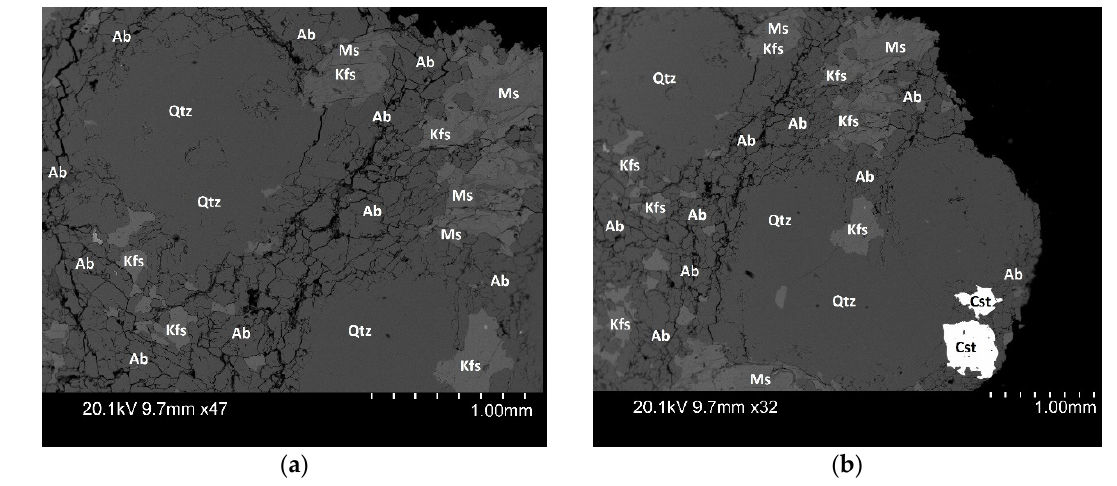
Figure 9. Backscattered electron image of two composite particles after IPB considering 20% compression ratio. The two composite particles ( a ) and ( b ) display unfractured quartz (Qtz) megacrysts, enclosed by a severely fractured matrix (albite (Ab), muscovite (Ms), and K-felspar (Kfs)), where larger fractures mainly develop in fine-grained albite.